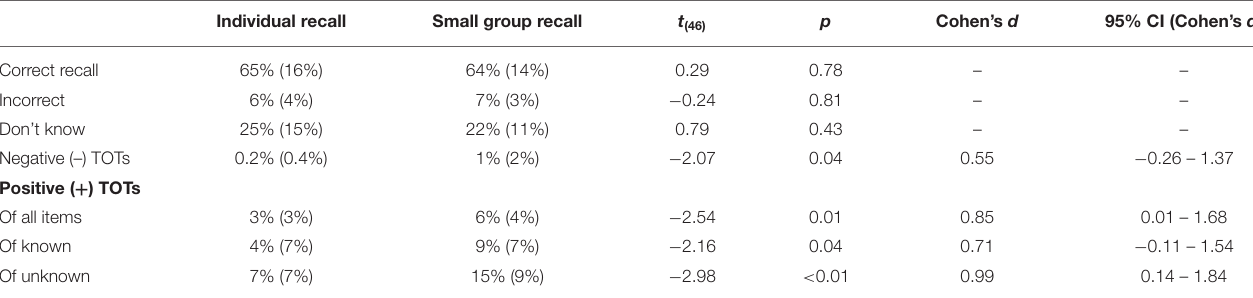
TABLE 2 | Mean (standard deviation) percentages of correctly recalled items, incorrect and “Don’t Know” responses, negative and positive TOT indexes, by recall condition, after removing trials with common TOTs (31% of TOTs).